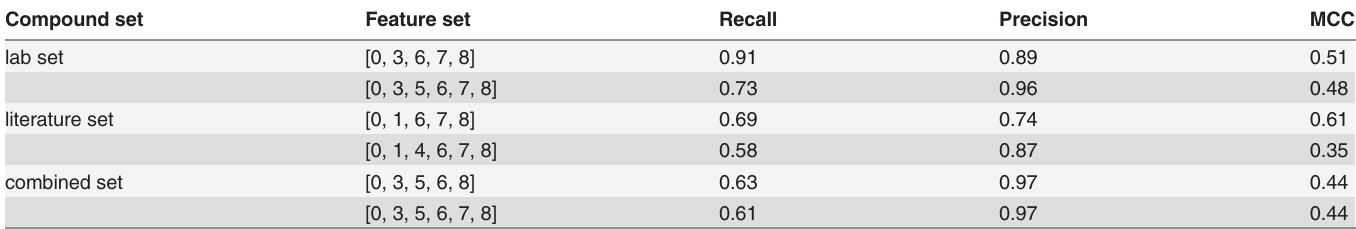
Table 2. Best pharmacophore validation results per set and 5 or 6 feature